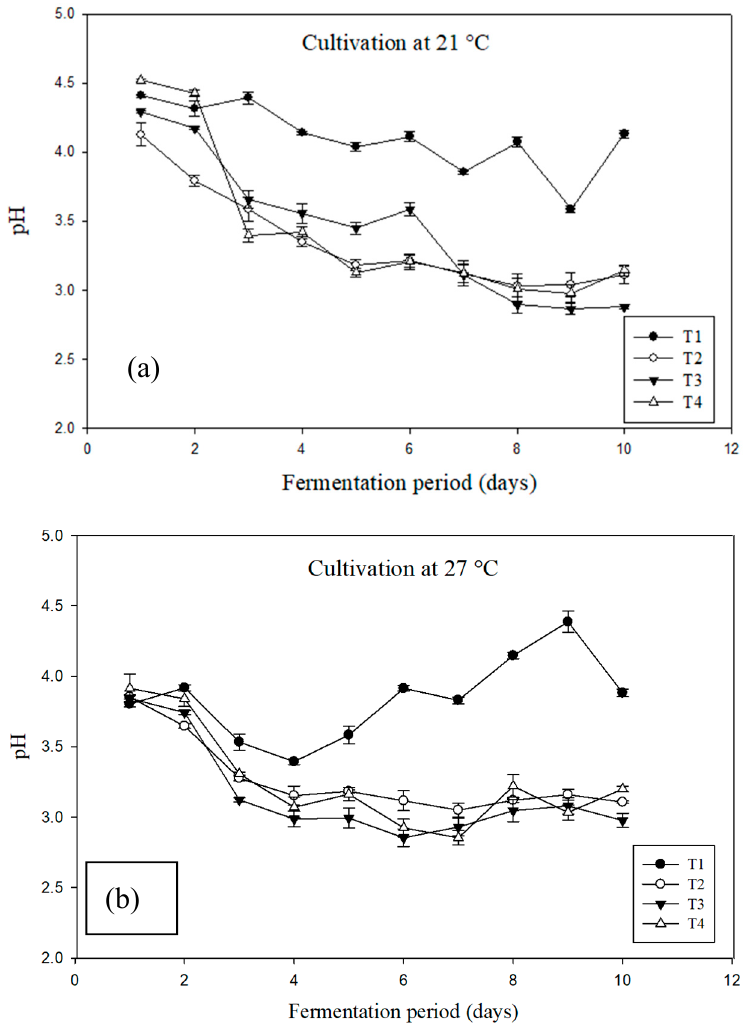
Figure 5. pH evolution of T. albobiverticillius strain 30548 liquid cultures grown at ( a ) 21 °C and ( b ) 27 °C with increasing concentration of sea salts (T1 0%, T2 3.65%, T3 6%, T4 9%)